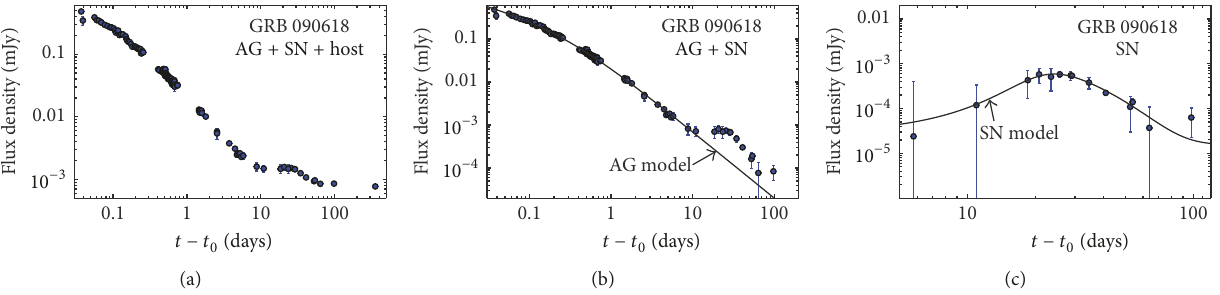
Figure 4: An example decomposition of the optical ( 𝑅 -band) light curve of GRB 090618 [10]. (a) For a given GRB-SN event, the single-filter monochromatic flux is attributed as arising from three sources: the AG, the SN, and a constant source of flux from the host galaxy. (b) Once the observations have been dereddened, the host flux is removed, either via the image-subtraction technique or by being mathematically subtracted away. At this point a mathematical model composed of one or more power laws punctuated by break-times is fit to the early light curve to determine the temporal behaviour of the AG. (c) Once the AG model has been determined, it is subtracted from the observations leaving just light from the